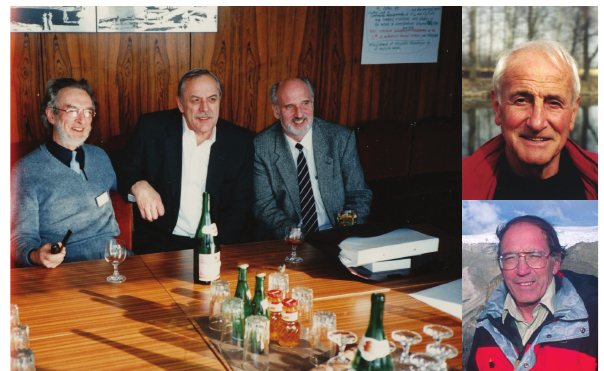
Fig. 3. The science trench at